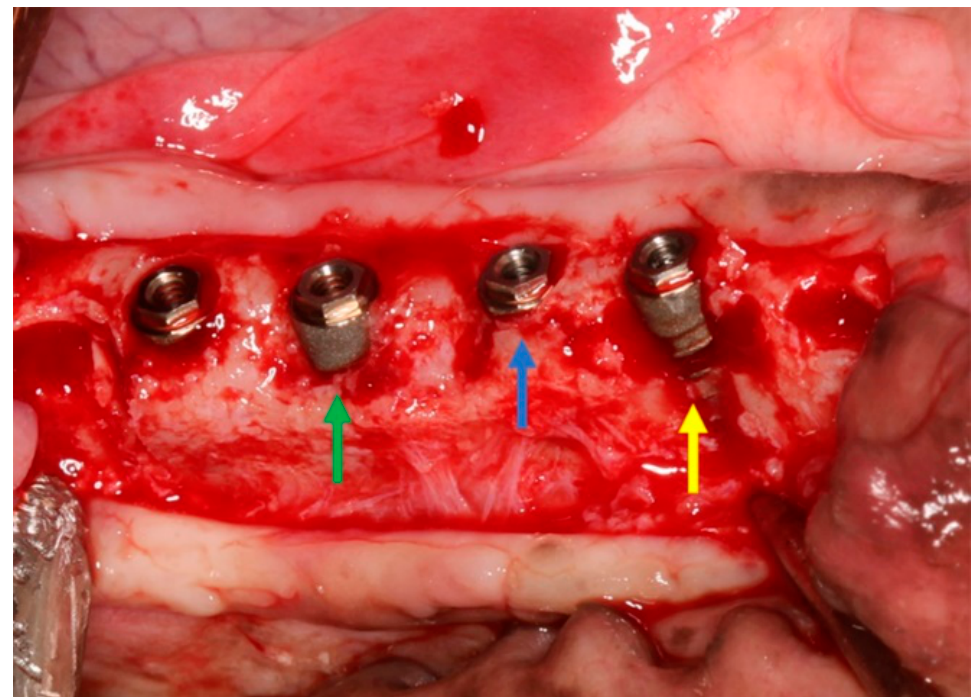
Figure 3. The clinical image shows the three conditions applied in the experiment: control site (blue arrow), induced buccal defect of 2 mm (green arrow), and 5 mm defect (yellow arrow).